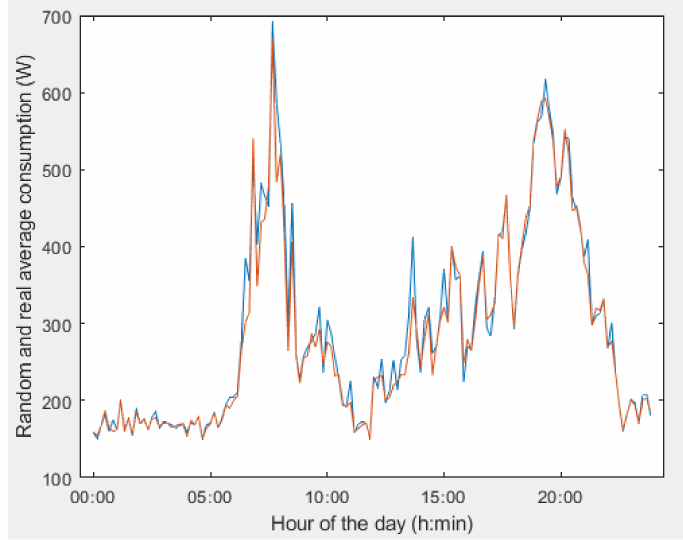
Figure 6. Random (blue) and real (orange) average consumption of the lighting during Sundays.